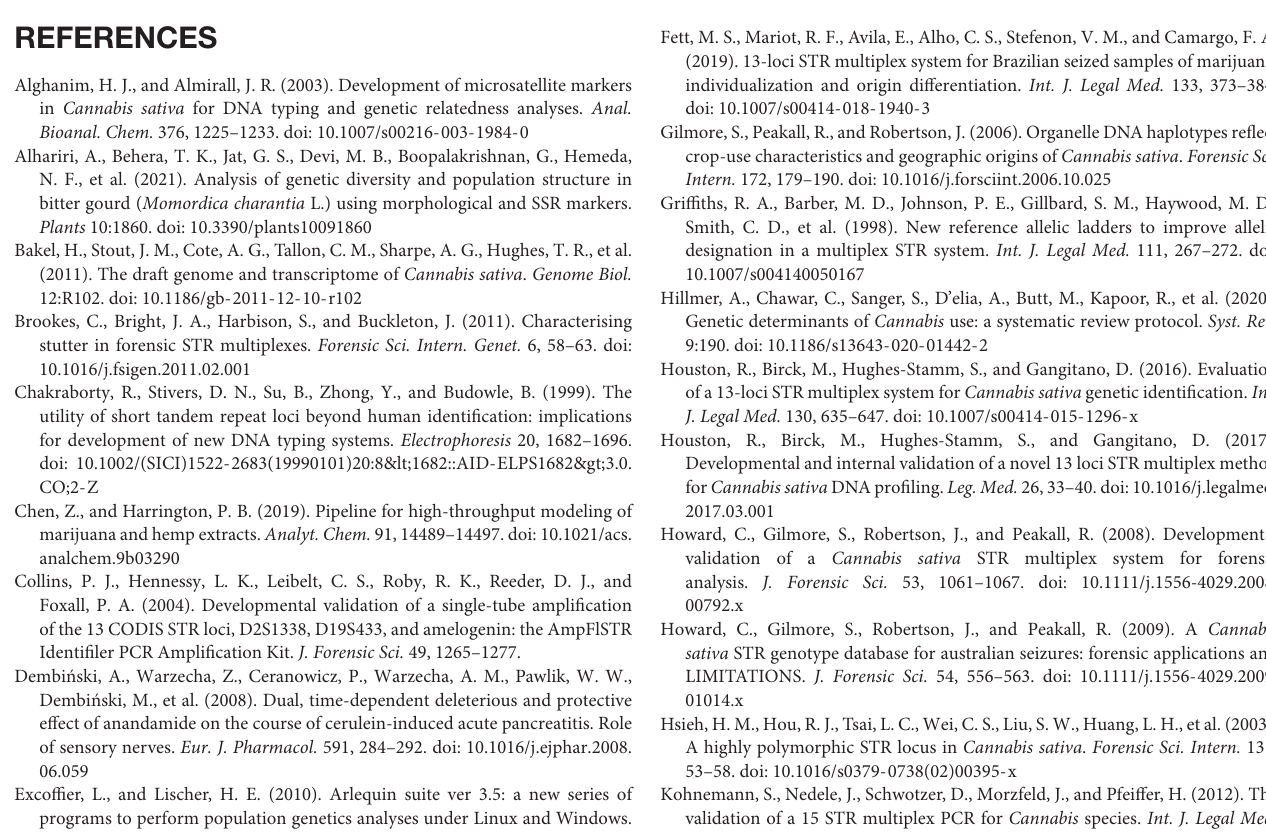
Supplementary Figure 1 | Electropherogram of the male control DNA with the Cannabis sativa 19-plex typing system. Supplementary Figure 2 | Electropherogram of the human control DNA (2800M) with the Cannabis sativa 19-plex typing system. Supplementary Figure 3 | Electropherogram of Humulus lupulus DNA with the Cannabis sativa 19-plex typing system. Supplementary Figure 4 | Electropherogram of Salvia japonica DNA with the Cannabis sativa 19-plex typing system. Supplementary Figure 5 | Electropherogram of Humulus scandens DNA with the Cannabis sativa 19-plex typing system. Supplementary Figure 6 | Electropherogram of Macaque sp. DNA with the Cannabis sativa 19-plex typing system. Supplementary Figure 7 | Electropherogram of the mixture DM001:DM030 at the ratios of 1:1 with the Cannabis sativa 19-plex typing system. Supplementary Figure 8 | The mixture DM001:DM030 was explored with serial mixed ratios. The average percentages of the detected minor alleles vs. the different mixed ratios are shown, and a full genotyping profile could be achieved at the ratios of 1:1, 1:3, and